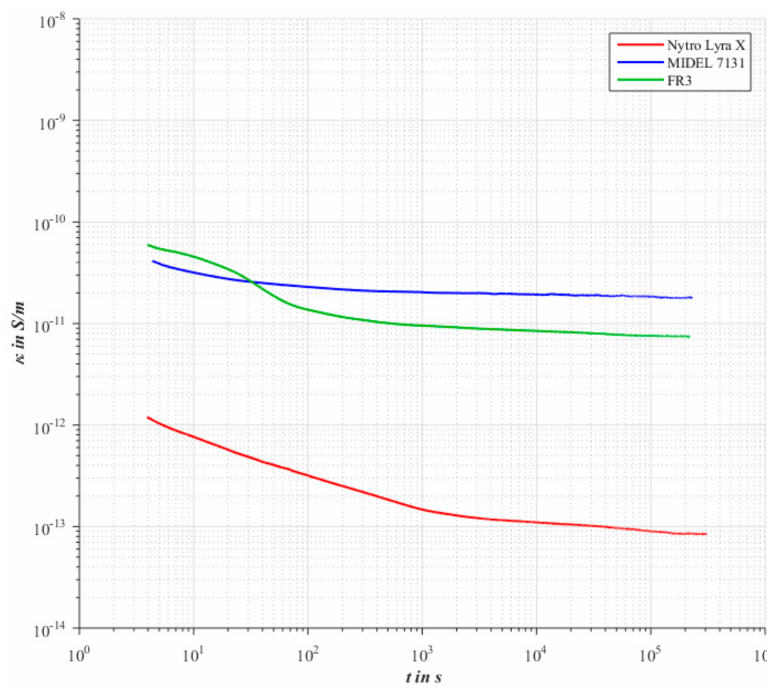
Figure 4. Pure oil gap